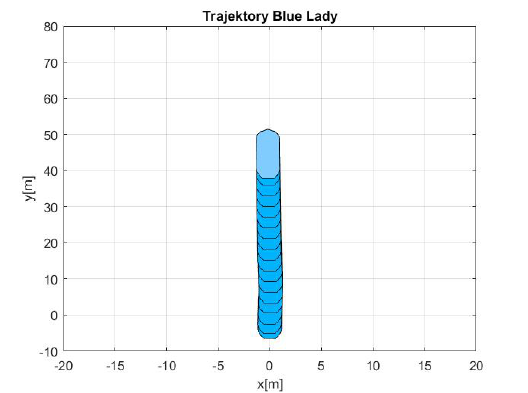
Figure 8. Trajectory ship ‘Blue Lady’ for ahead maneuver with longitudinal velocity u = 0.1 [m/s], v = 0.0 [m/s], r = 0.0 [rad/s] and maneuver duration 500 [s].